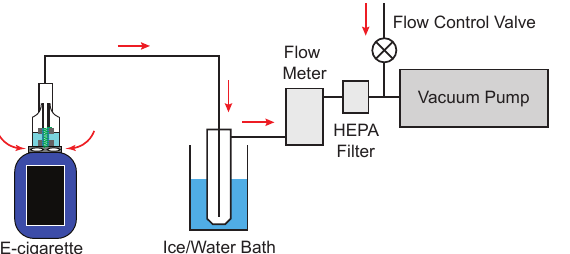
Figure 2. Experimental apparatus. Red arrows indicate direction of air flow through the system. A flow meter was used to measure the flow rate through the device, while a flow control needle valve was used to set the flow rate. A high-efficiency particulate air (HEPA) filter was placed in the line to remove excess particles before air flow entered the